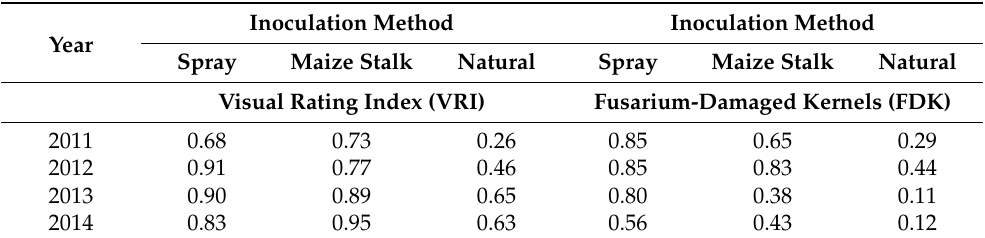
Table 2. Heritability estimates for the visual rating index (VRI) and the percentage of Fusarium- damaged kernels (FDK) in 25 wheat genotypes evaluated under three inoculation methods (spray, maize stalk and natural) in 2011, 2012, 2013, and 2014. Year